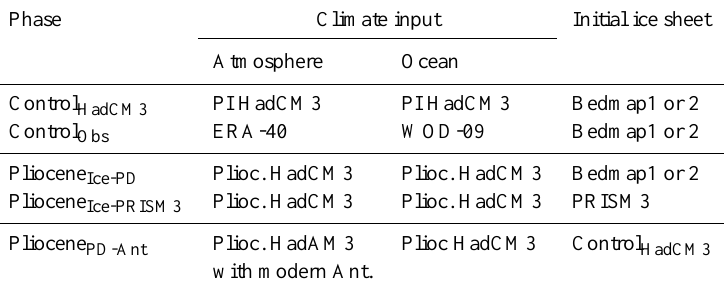
Table 1. Experiments for PLISMIP-ANT following Dolan et al. (2012). Two phases are carried out, a control phase and Pliocene phase. Forc- ing climatology’s for Control HadCM3 and the Pliocene experiments are taken from HadCM3 with PRISM3 boundary conditions, Control Obs uses ERA-40 reanalysis and ocean temperatures from WOD-09. The fifth experiments uses HadAM3 surface climate and HadCM3 ocean temperatures. Initial ice sheets are taken from Bedmap1 (Lythe et al., 2001) or Bedmap2 (Fretwell et al., 2013) and PRISM3 (Dowsett et al., 2010). PI: